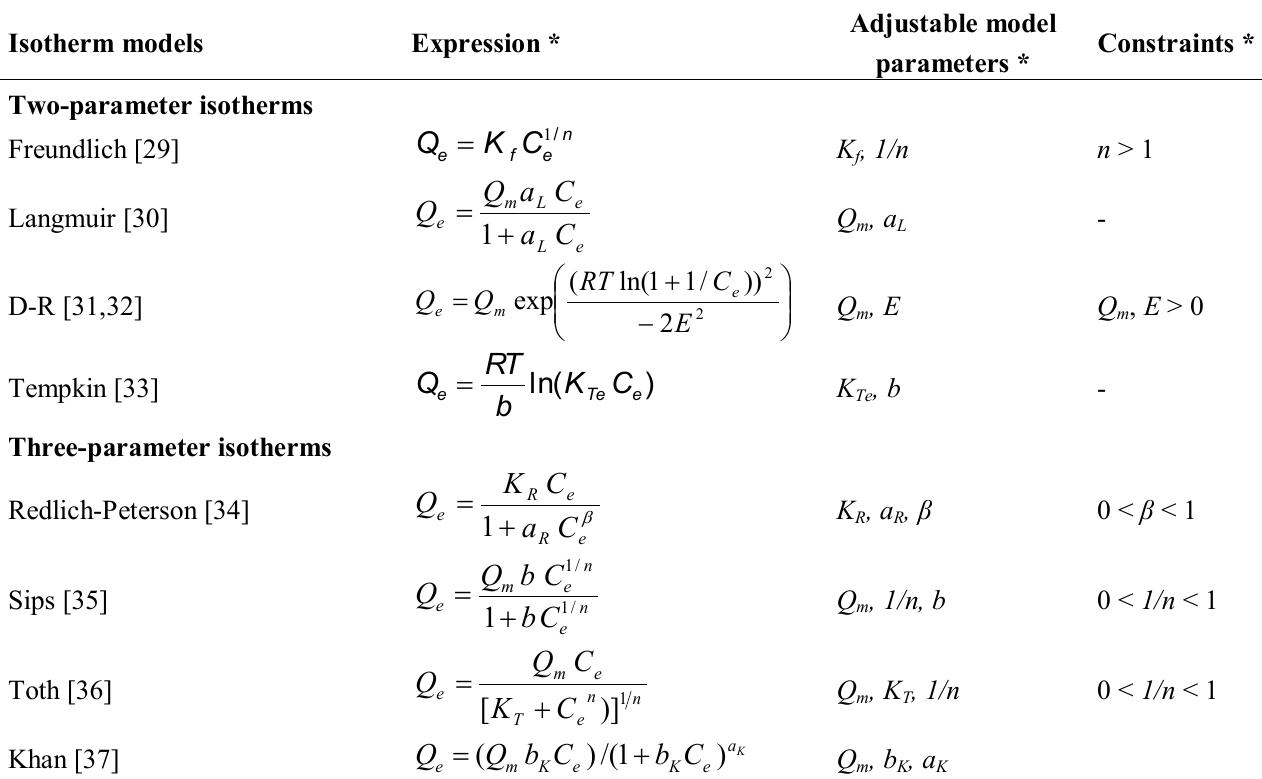
Table 1. Expression of two-parameter and three-parameter adsorption isotherm models. Isotherm